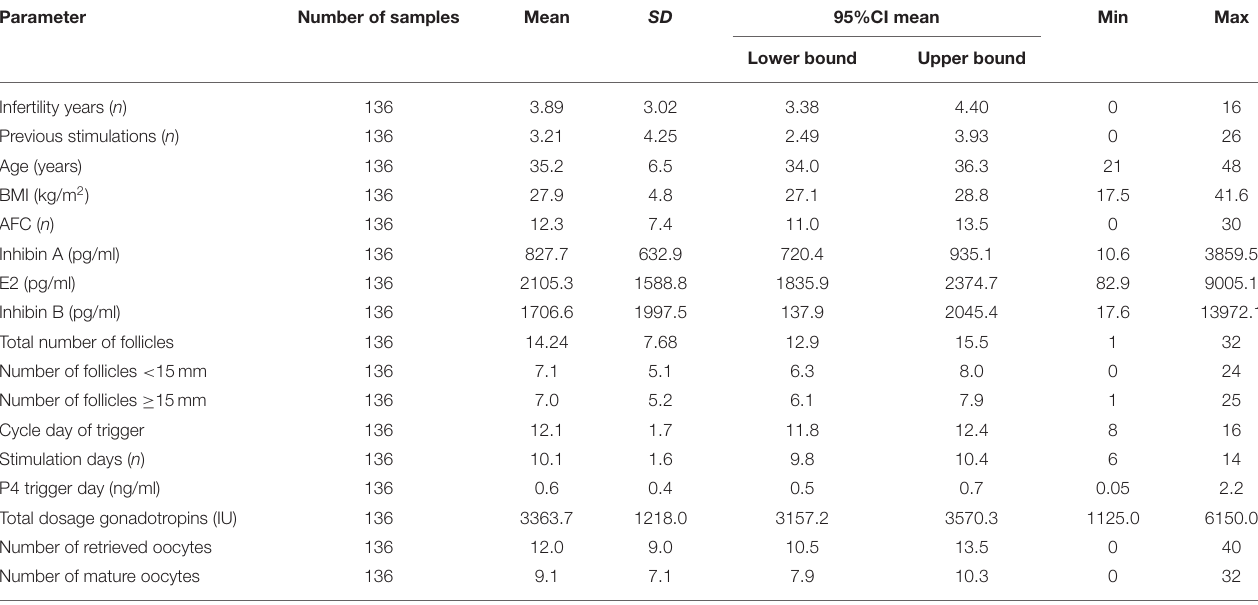
TABLE 2 | Patients’ characteristics and results of AFC, Inhibin A, estradiol, and Inhibin B on the day of final oocyte maturation. Parameter Number of samples